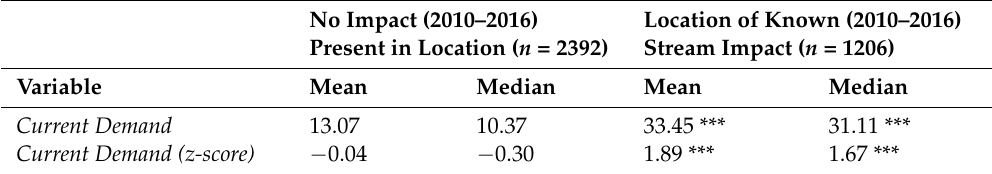
Table A5. Results of statistical tests for modeled